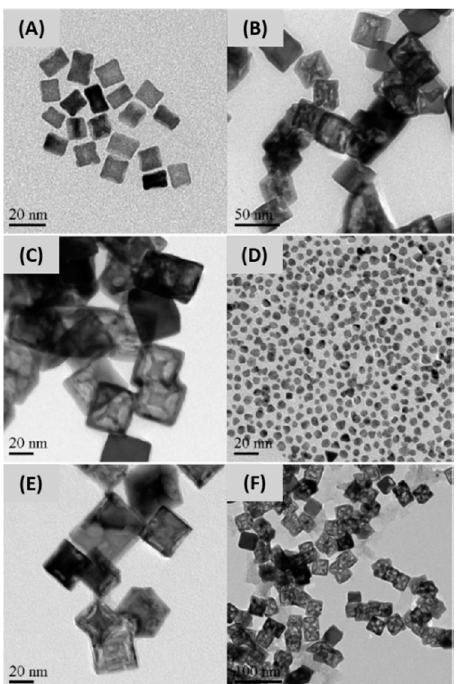
Figure 13. TEM images of Pd-Pt NPs using the typical reaction conditions in ( A ) 80 s; ( B ) 120 s; ( C ) 140 s; ( D ) 0 mg of KI; ( E ) 25 mg of KI; ( F ) 100 mg of KI. Adapted with permission from Reference 51. Copyright 2014 American Chemical Society.